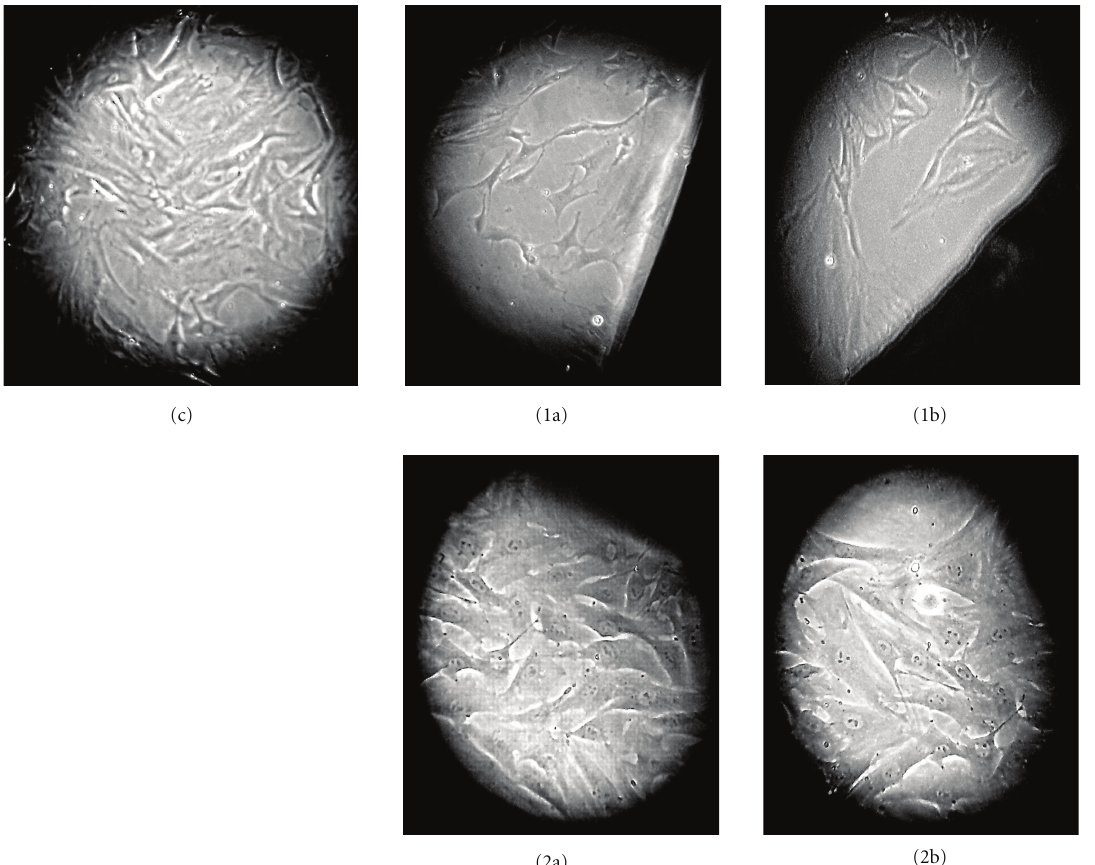
Figure 10: Morofology of MSCs calctivated with the NiTi-A and NiTi-B specimens: cultivation with no specimen (c), cultivation for 3 days with NiTi-A (1a) and NiTi-B (1b); cultivation for 14 days with NiTi-A (2a) and NiTi-B (2b). Optical microscope, magnification is × 50 for (c), (1a), (1b) and × 100 for (2a), (2b).